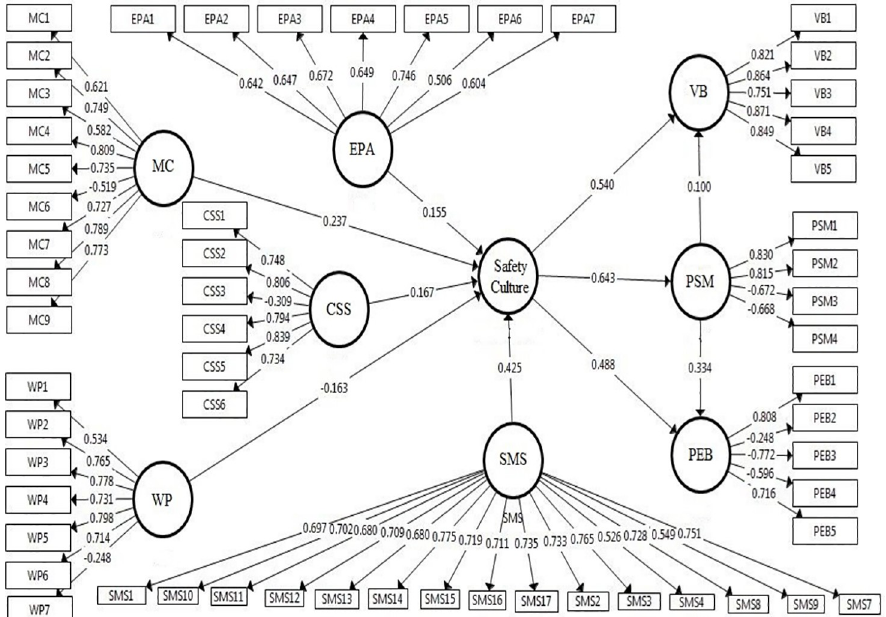
Fig 2. An initial structural model with standardized path